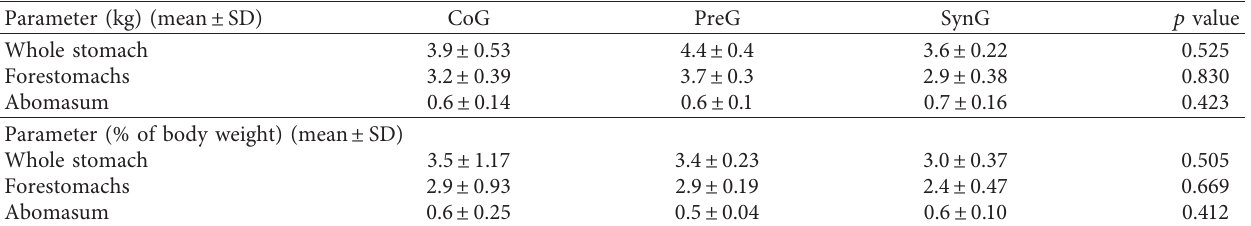
Table 2: Weight (kg) and relative weight of different parts of the stomach (% of body